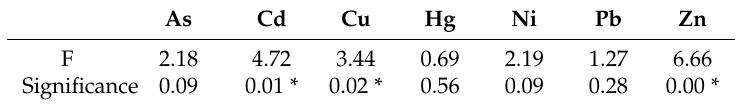
Table 3. ANOVA of heavy metals for different land uses in the agricultural soil. Table 3 ANOVA of heavy metals for different land uses in the agricultural soil. As